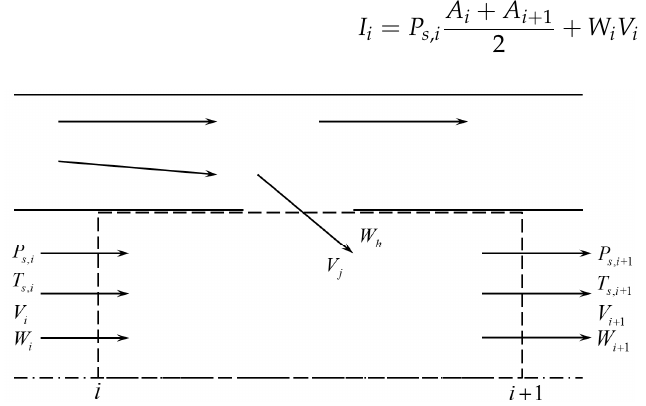
Figure 1. Control body in the flaming cylinder.